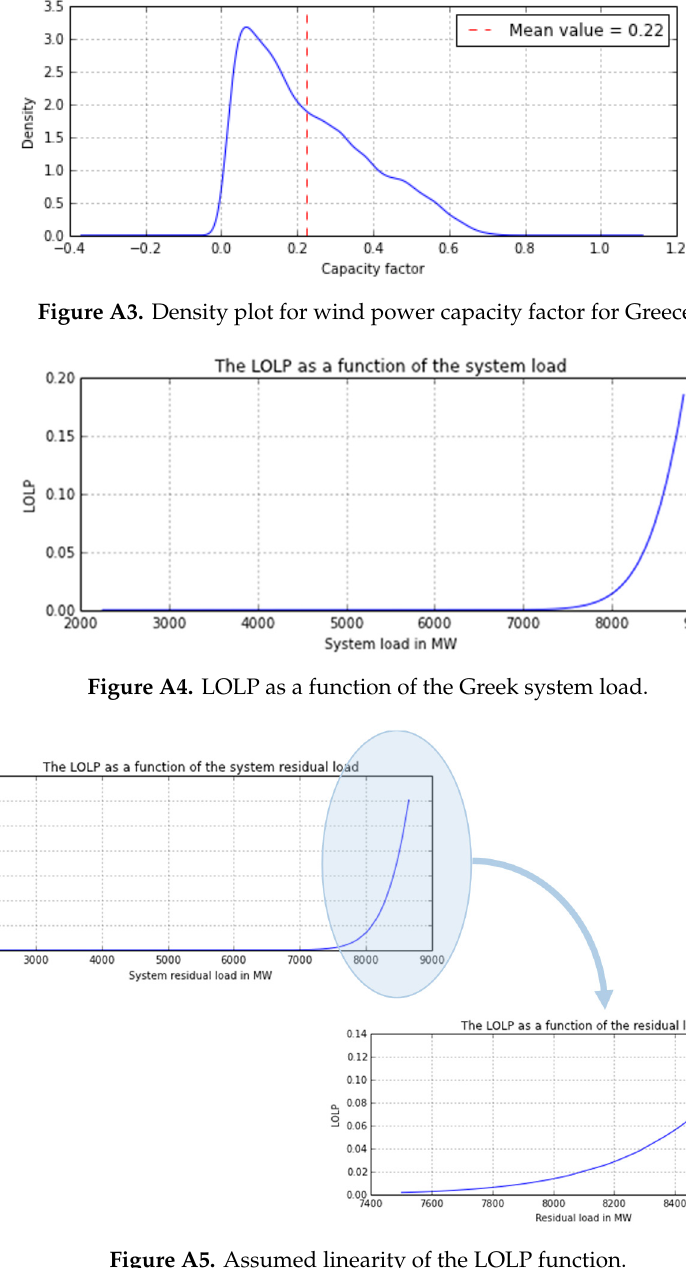
Figure A5. Assumed linearity of the LOLP function.